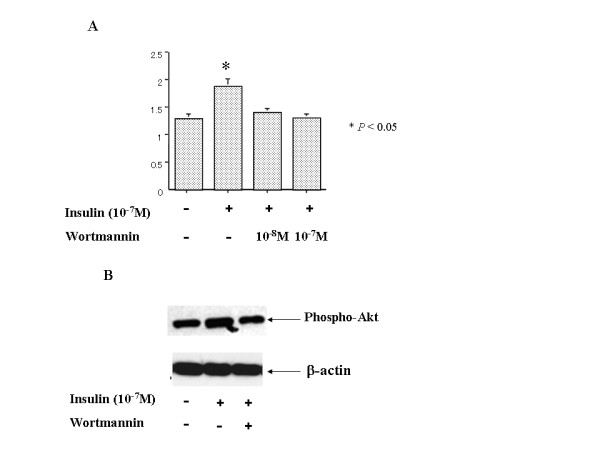
A: Effect of wortmannin pretreatment on the insulin-induced cell proliferation of A-MEC-LAP cells. The cells were pretreated with 10-8 M or 10-7 M wortmannin before 1 h stimulation with 10-7 M insulin. Insulin-induced cell proliferation was significantly inhibited with 10-8M or 10-7 M wortmannin. * p < 0.05 B: Effect of wortmannin pretreatment on insulin-induced AKT activation of A-MEC-LAP cells. Pretreatment with 10-7 M wortmannin inhibited insulin-induced AKT activation in A-MEC-LAP cells.